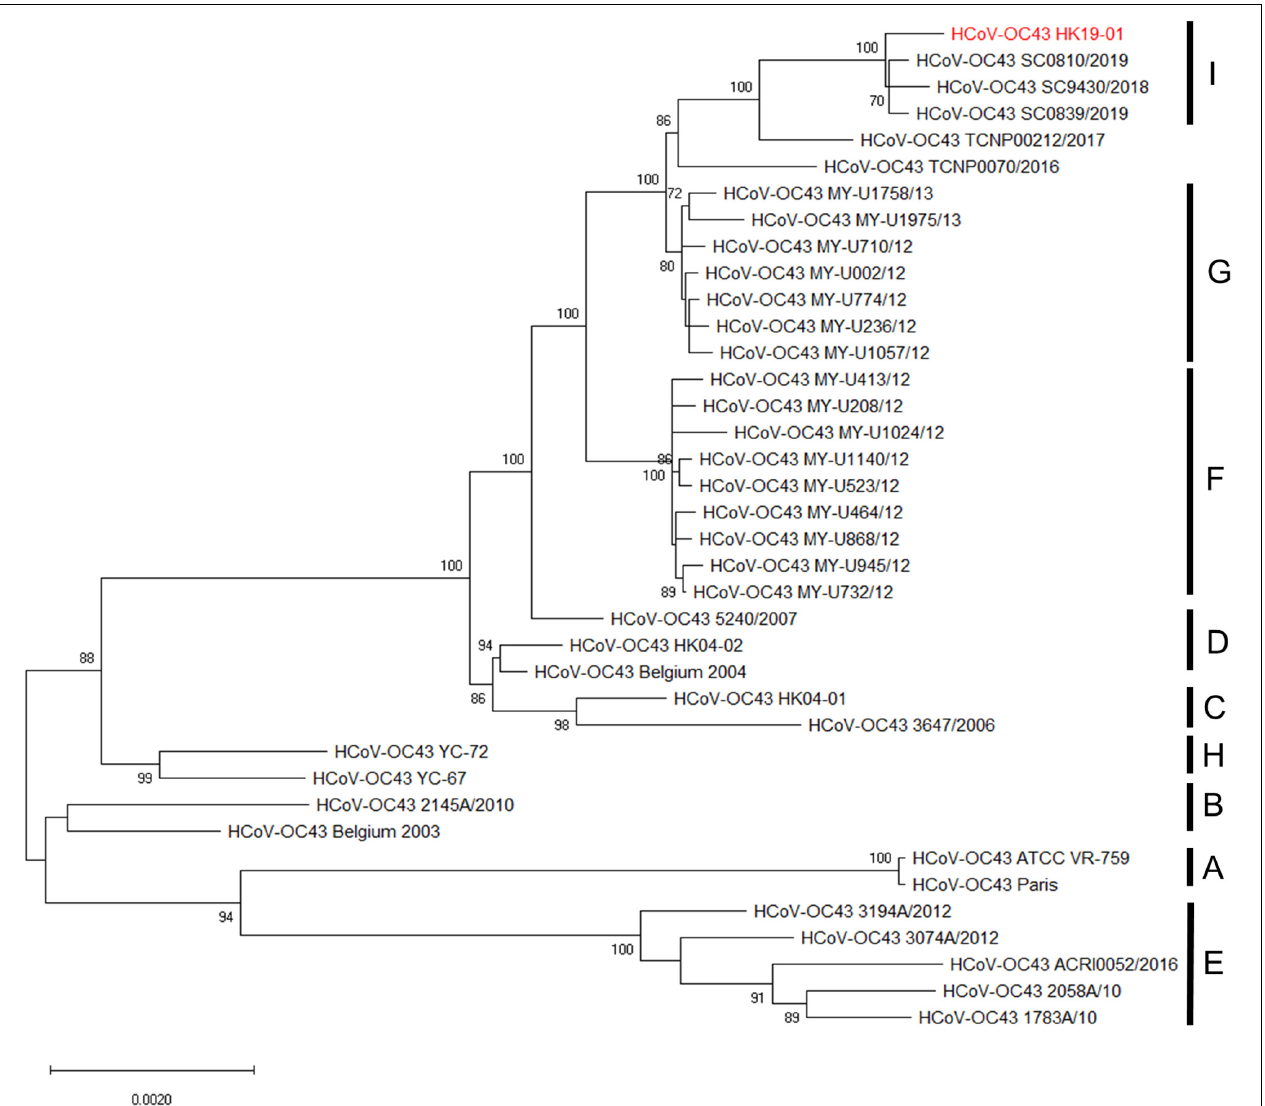
( Table 1 ). HCoV-OC43 at a level of 6.46 × 10 3 copies/ml was also detected from his pleural fluid 2 days before his death.